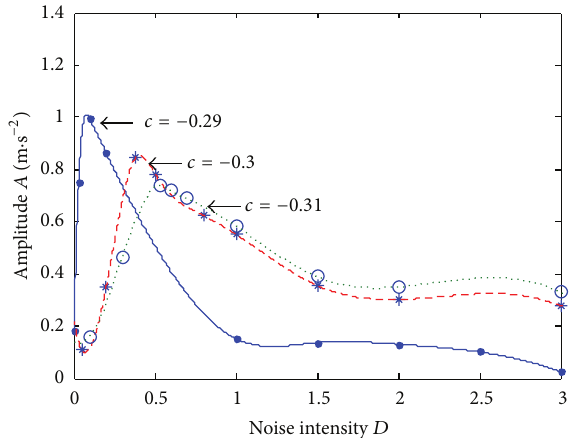
Figure 8: The variation curve of the output signal amplitude with the addition of noise 𝐷 under different 𝑐 value.